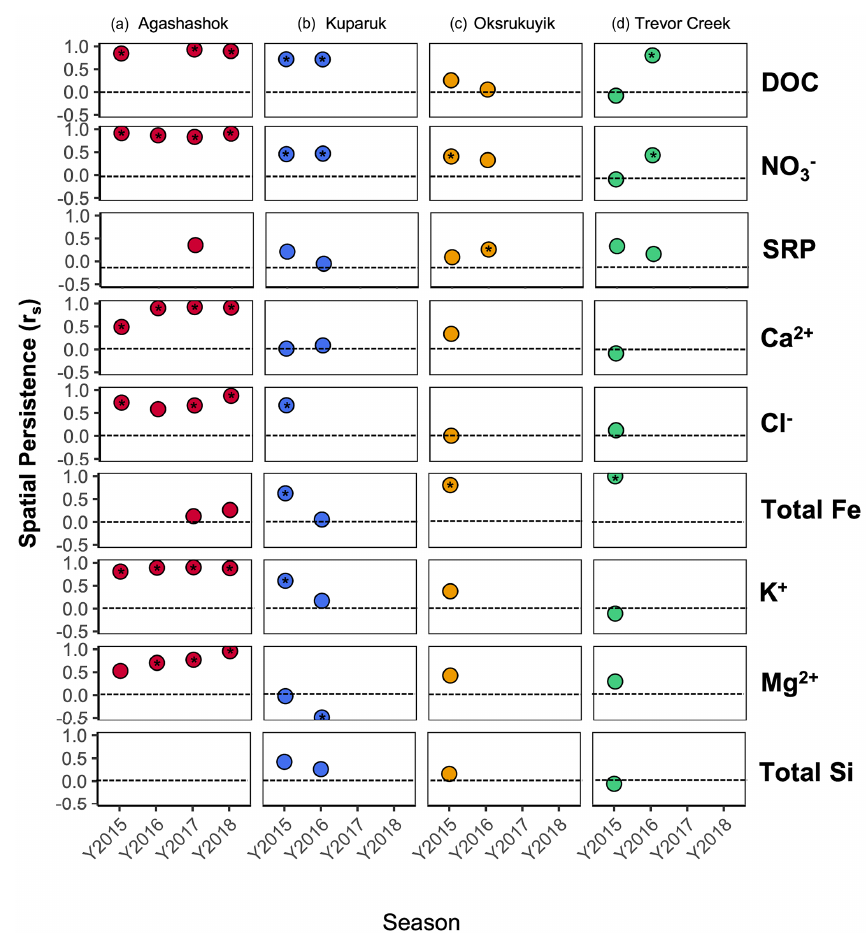
Figure 9. Scatter plot of spatial stability ( r s ) for each repeated sampling for the (a) Agashashok, (b) Kuparuk River, (c) Oksrukuyik Creek, and (d) Trevor Creek watersheds for select reactive (e.g., DOC, NO 3 − , and SRP) and conservative solutes (Ca 2 + , Cl − , Fe (total for NPS/USGS; nominally dissolved for TFS), K + , Mg 2 + , and total Si). When data were not present, there is no spatial stability reported. When Spearman’s rank correlation ( r s ) is significant, this is denoted by an asterisk ( ∗ ) within the